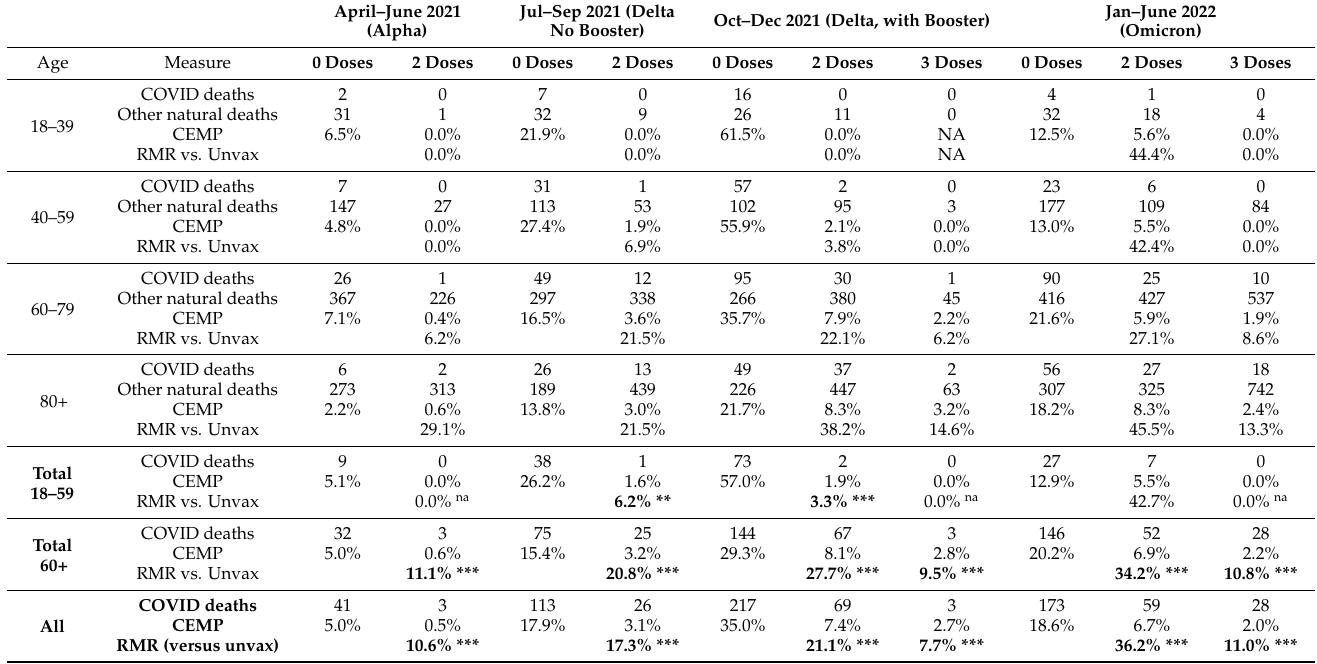
Table 2. CEMP and Relative Mortality Risk (RMR) by Age Group and Time